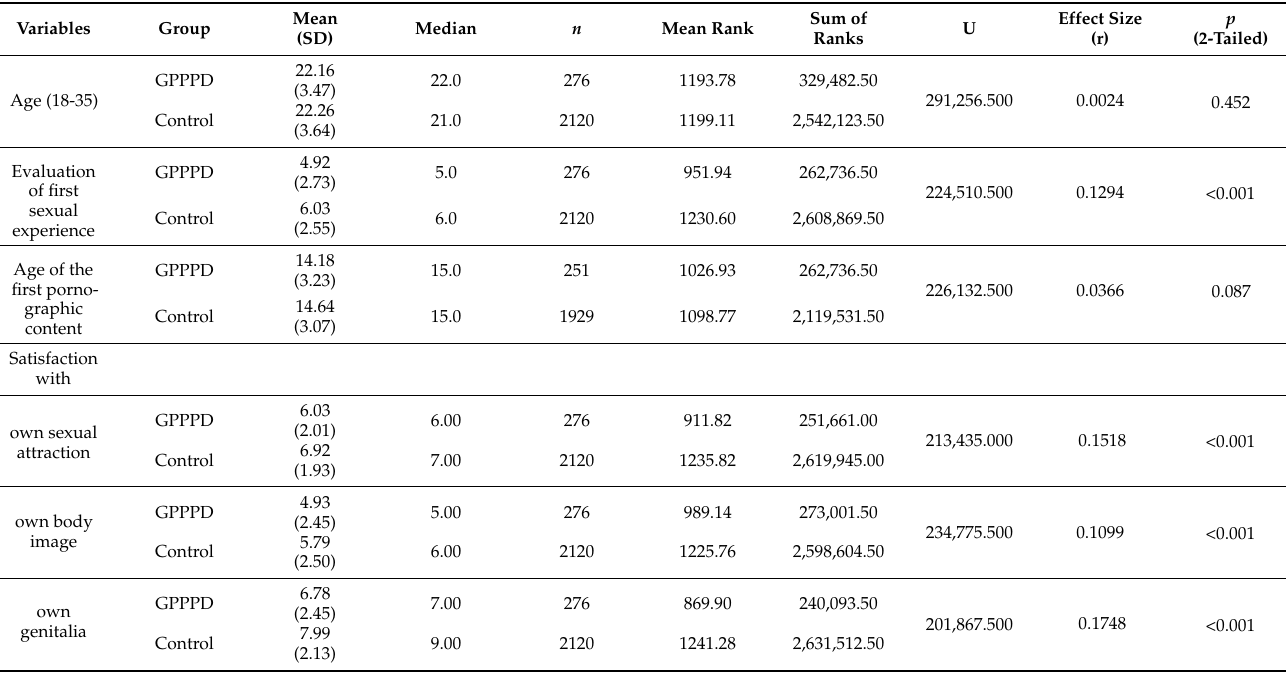
Table 4. Differences between the GPPPD group and control group in sexual experience, age of